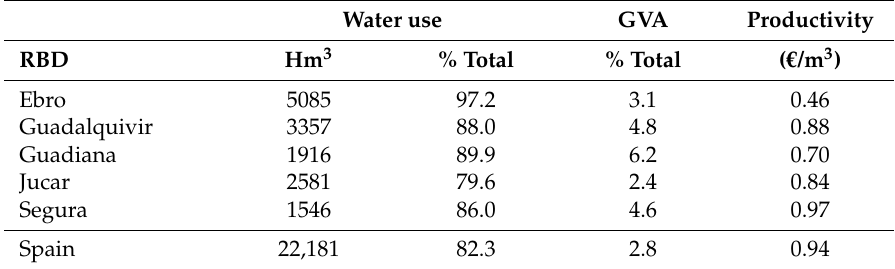
Table 2. Agricultural water use, GVA and productivity in Spanish RBDs (2012). Water use GVA Productivity RBD Hm 3 % Total % Total ( € /m 3